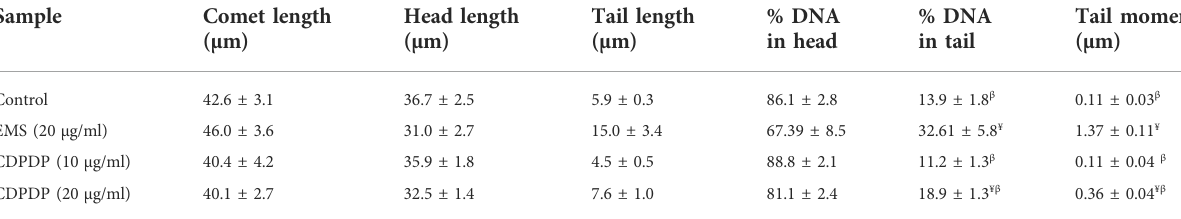
TABLE 6 Genotoxicity of CDPDP on blood lymphocytes was assessed using comet measurements.